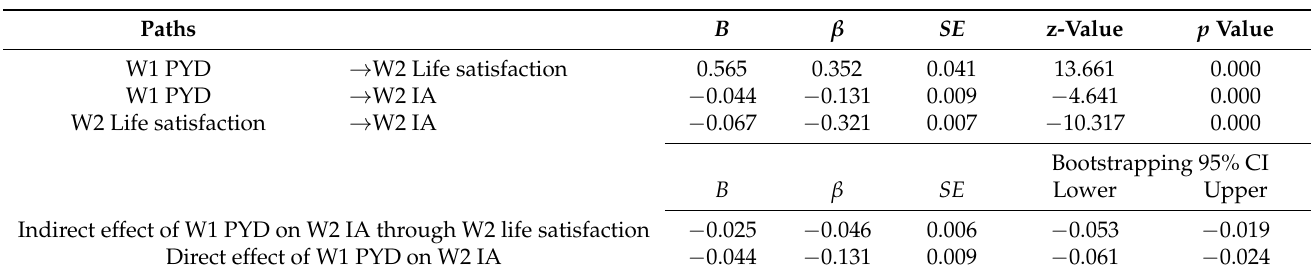
Table 8. Results of SEM